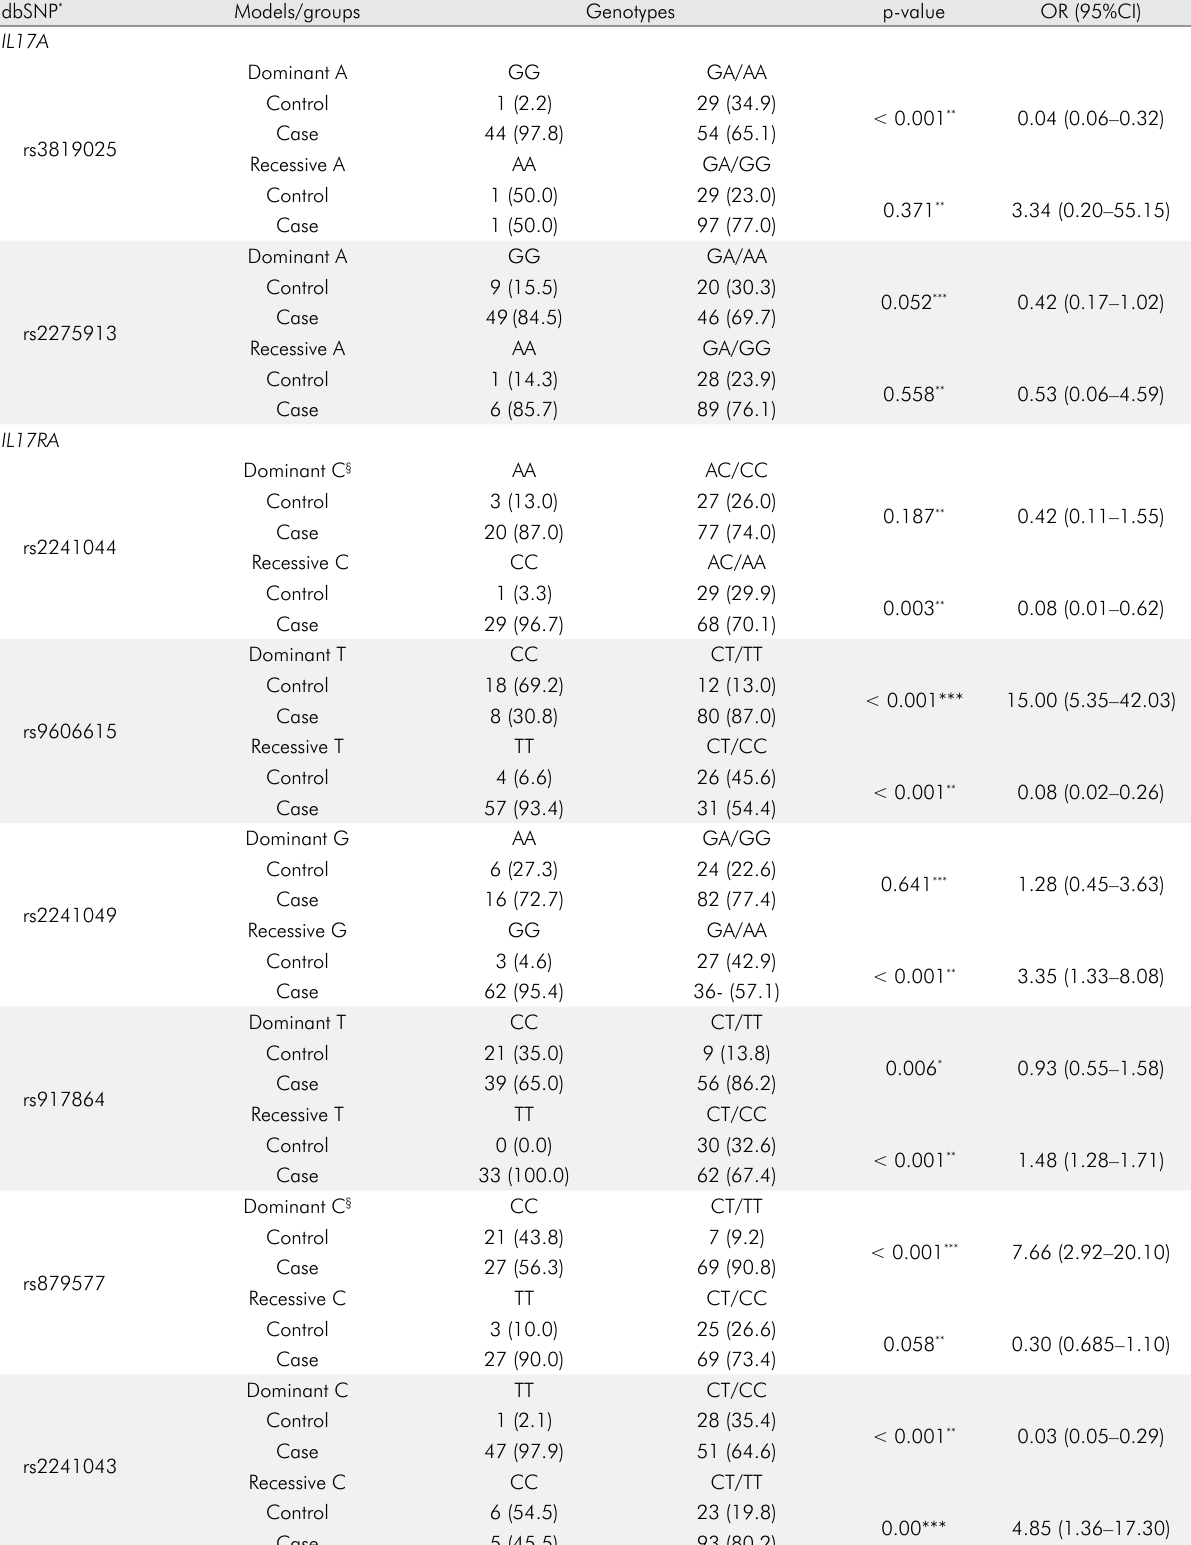
Table 3. Genotypic analysis for the dominant and recessive models of the IL17A and IL17RA genes. dbSNP